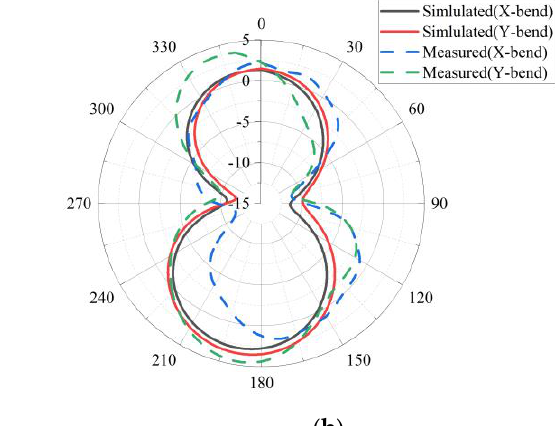
Figure 12. The simulation and measurement of return loss after structural deformation.